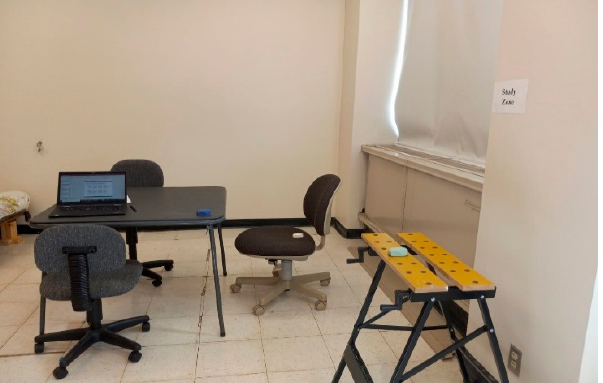
Figure 4. Placement of one of the proximity sensors in the ‘study-zone’.